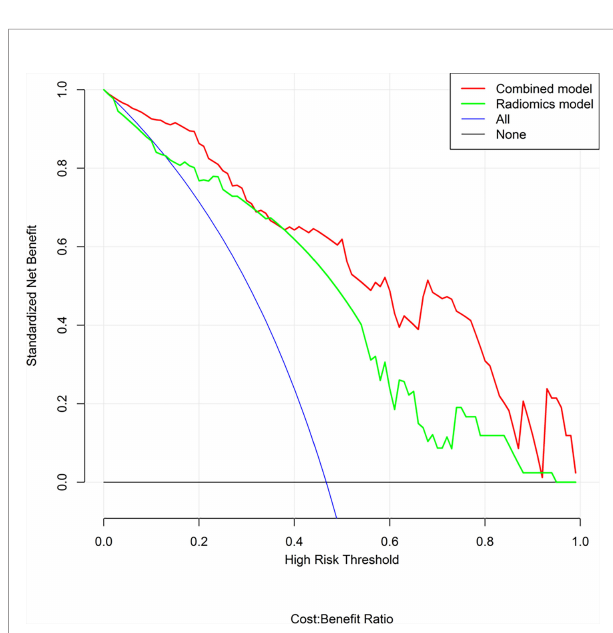
FIGURE 6 | Decision curve analysis (DCA) for the radiomics nomogram and radiomics model. The DCA indicated that more net bene fi ts within the most of thresholds probabilities were achieved using the radiomics